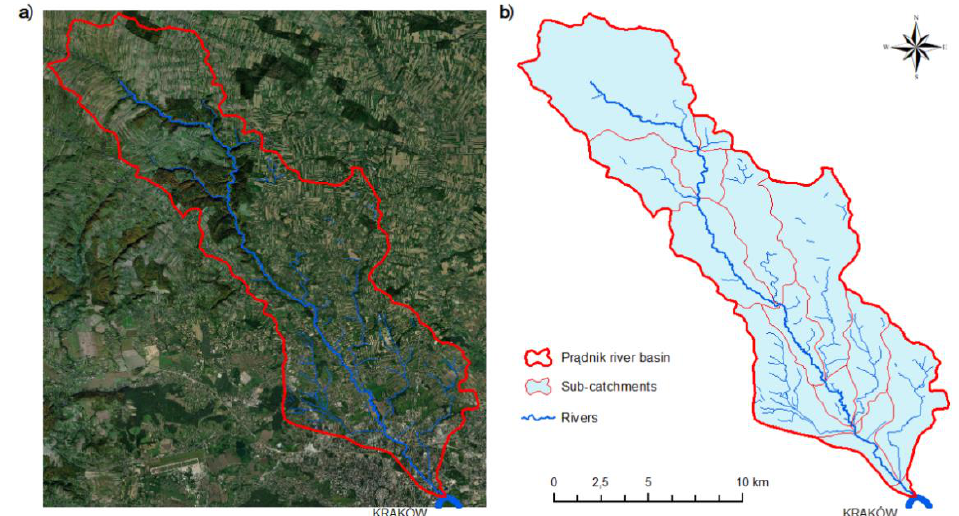
Figure 1. Orthophoto map of the Prądnik river basin ( a ) and its subcatchments ( b ).